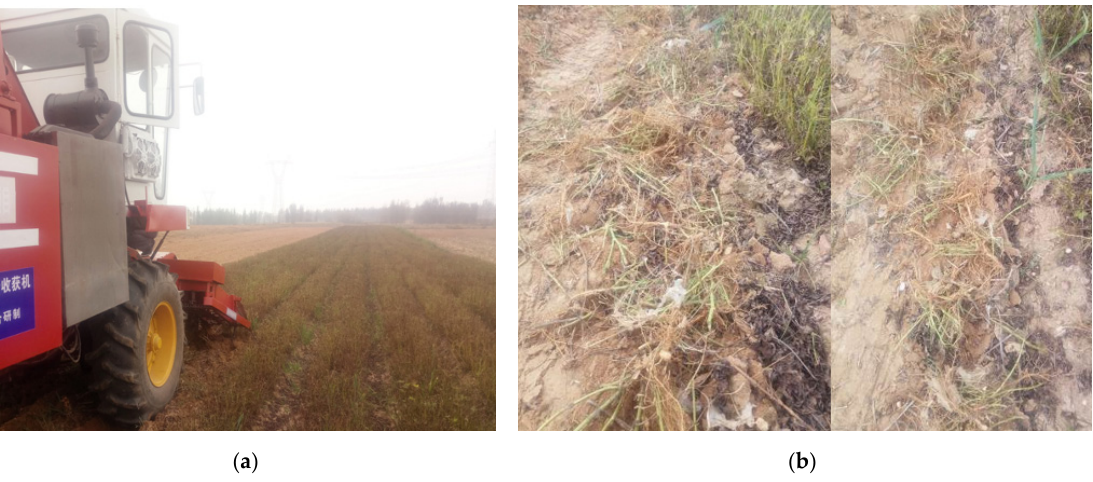
Figure 10. Field test. ( a ) Field test scene. ( b ) Peanut root-disk after pod-picking.